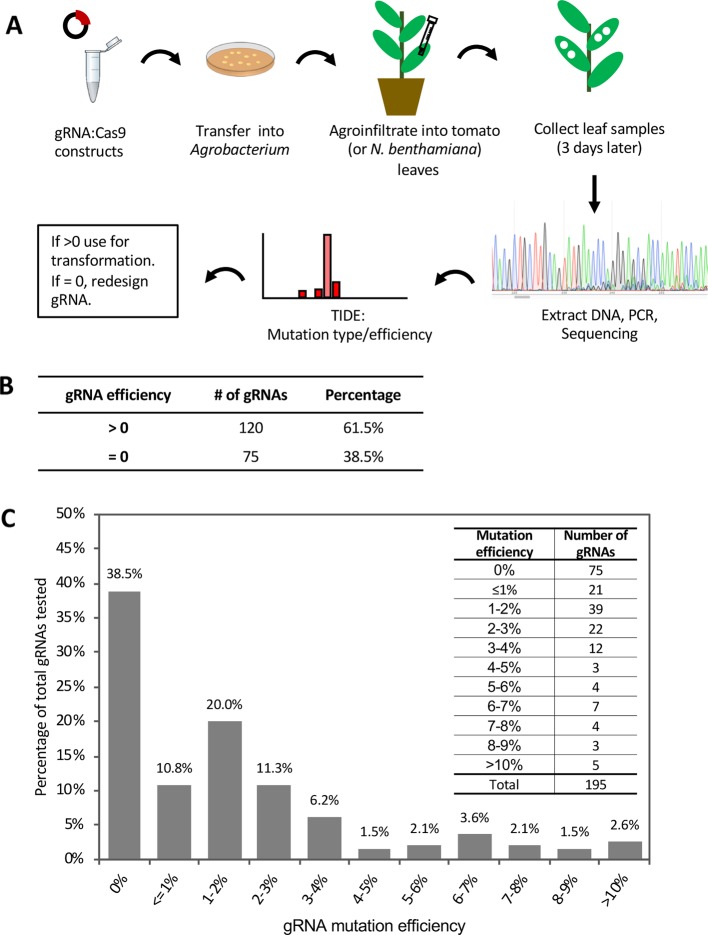
Evaluation of gRNA-mediated mutation efficiency by agroinfiltration in tomato leaves. See also 
Figure S1
 and 
Table S1
. (A) Schematic showing the workflow of guide RNA (gRNA) evaluation by agroinfiltration. (B) Summary of gRNA efficiency tested by agroinfiltration. (C) The distribution of mutation efficiencies of the 195 gRNAs. Inset on the top right shows the number of gRNAs in each mutation efficiency range. TIDE (https://tide.deskgen.com) was used to calculate mutation efficiency by identifying the predominant types of insertions and deletions (indels) in the DNA of a targeted cell pool.